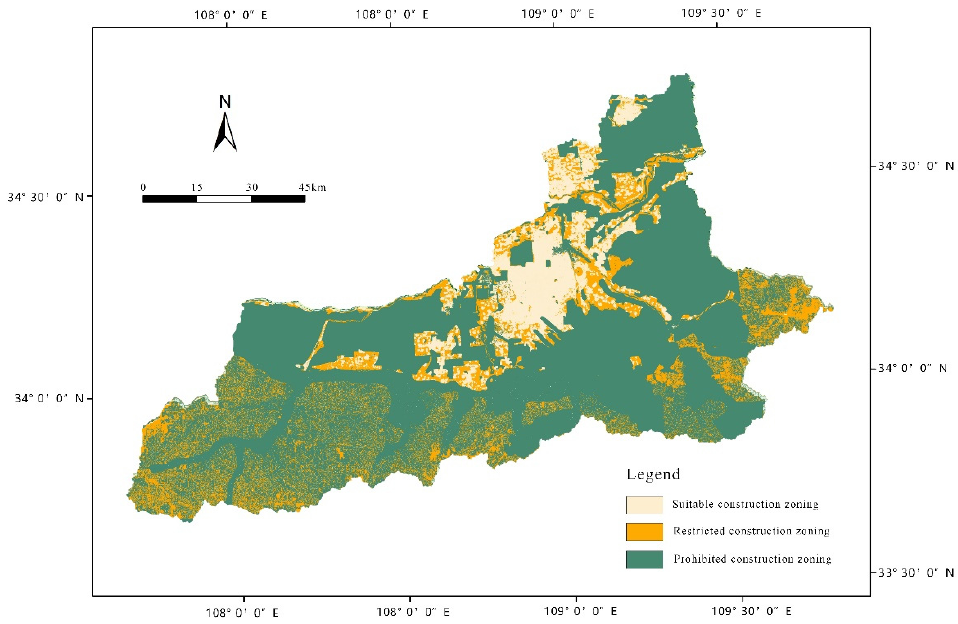
Figure 10. The integration result of urban spatial control zoning.